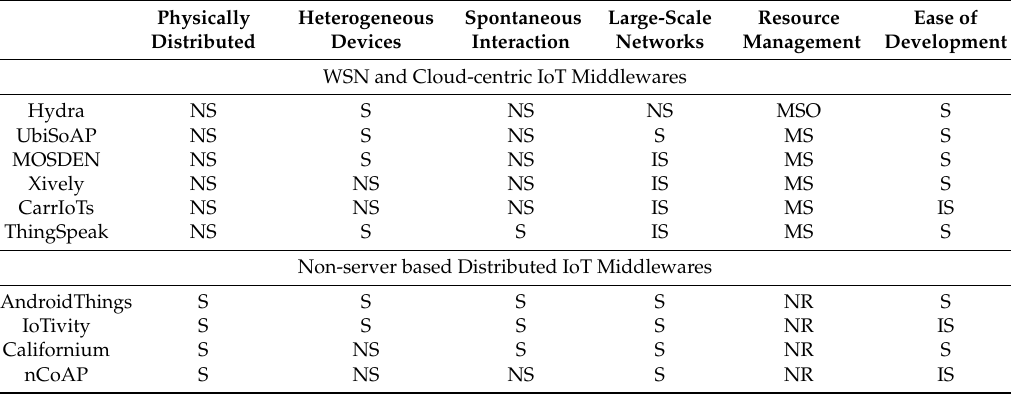
Table 1. Summary of the middlewares: supported functional